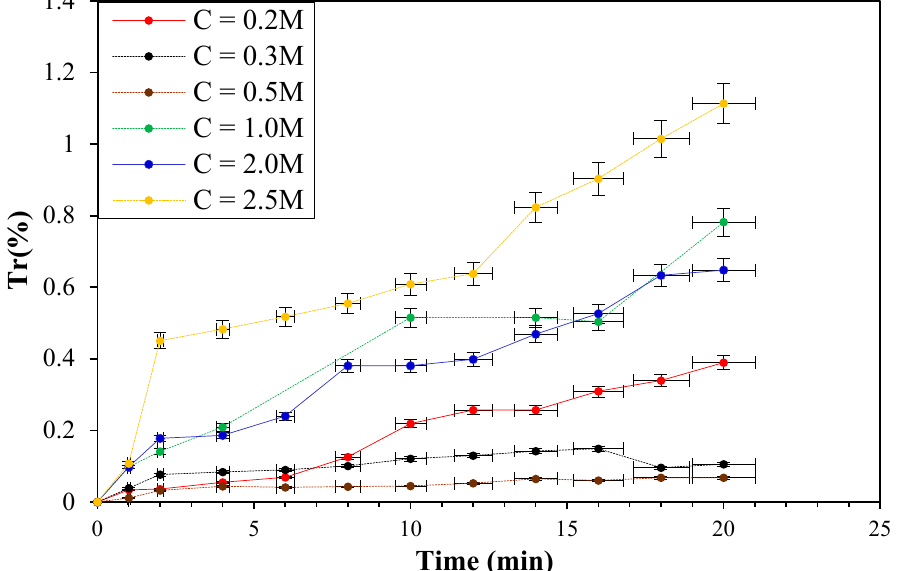
Figure 3. Influence of the internal phase concentration on the emulsion stability ([Span 80]: 2% wt./wt., w: 250 rpm, int/org ( v / v ): 1/1, emu/ext ( v / v ): 0.15/1, t emuls = 3 min, internal phase: HNO 3 ).